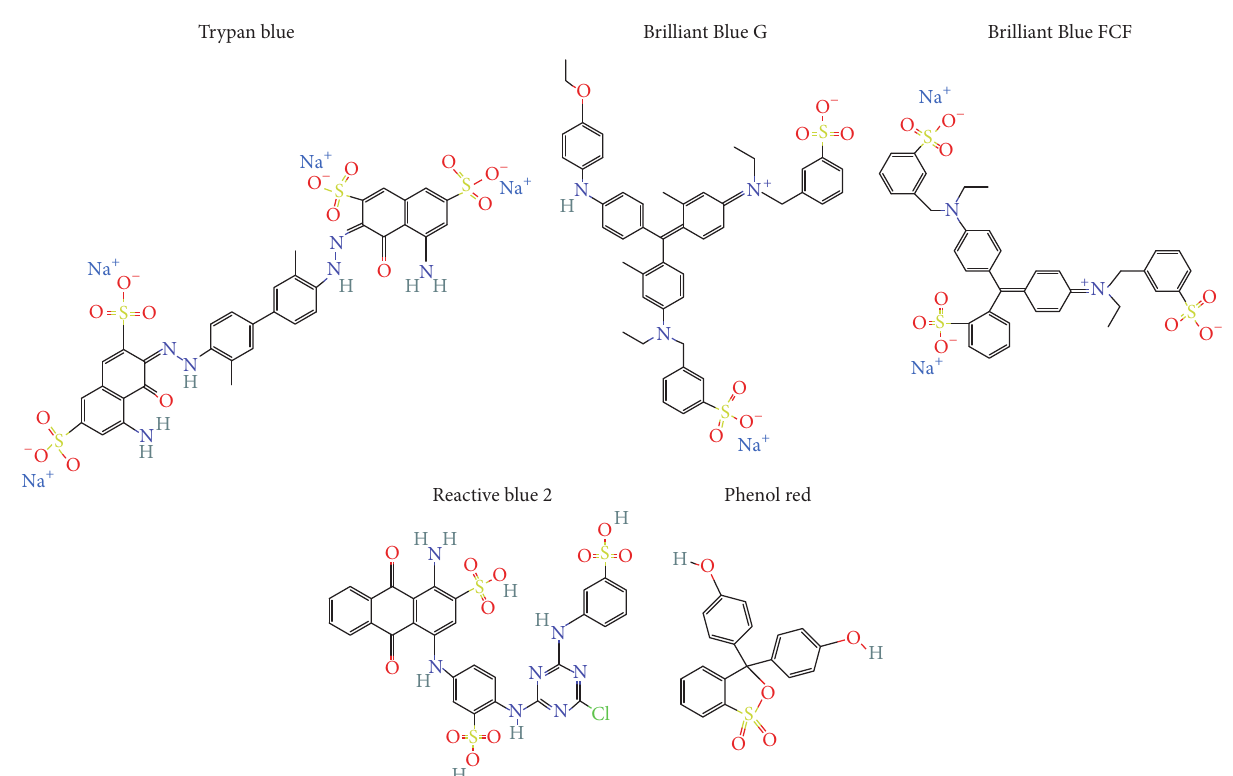
Figure 1: Structure of the dyes, which are P2 receptors